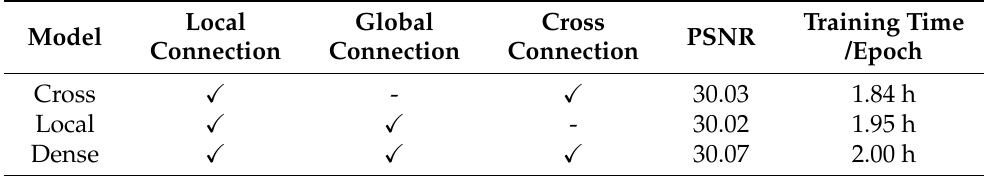
Table 4. Ablation study of FFN layer on Kodak24 .